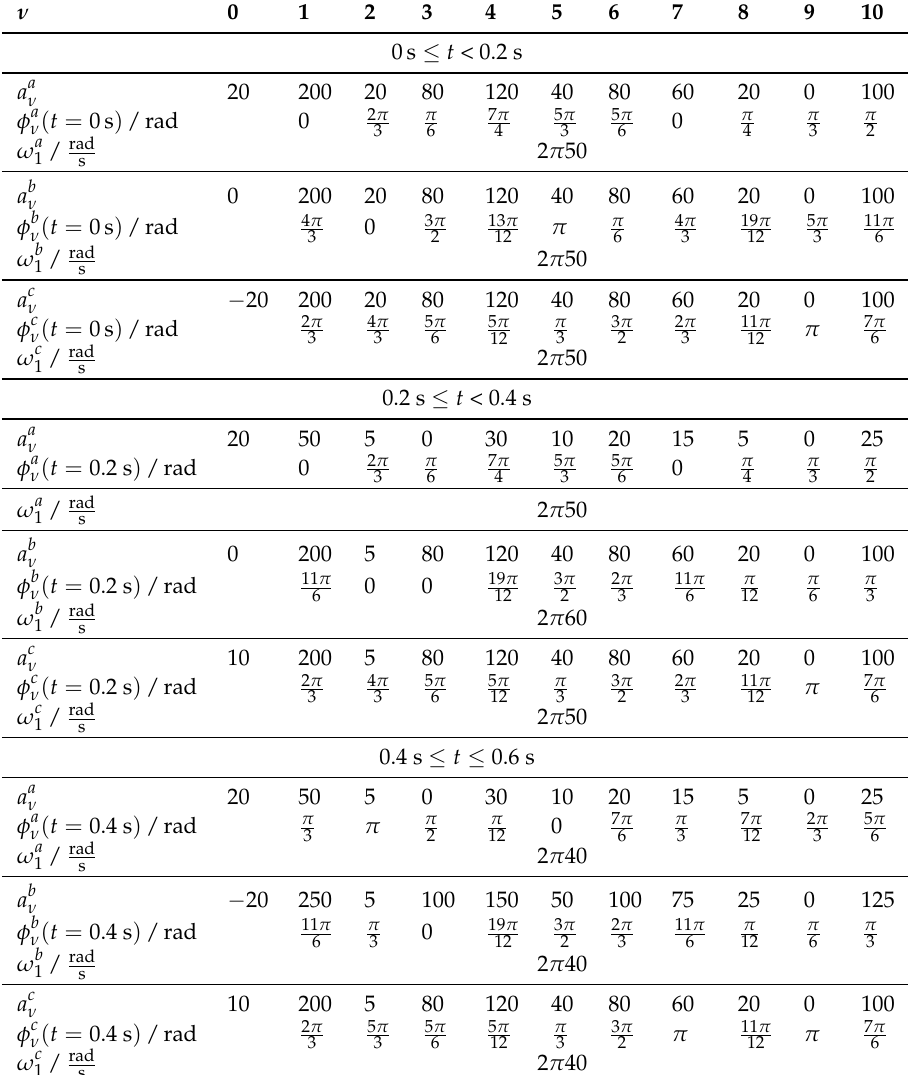
Table 4. Signal variables for Scenarios (S3) and